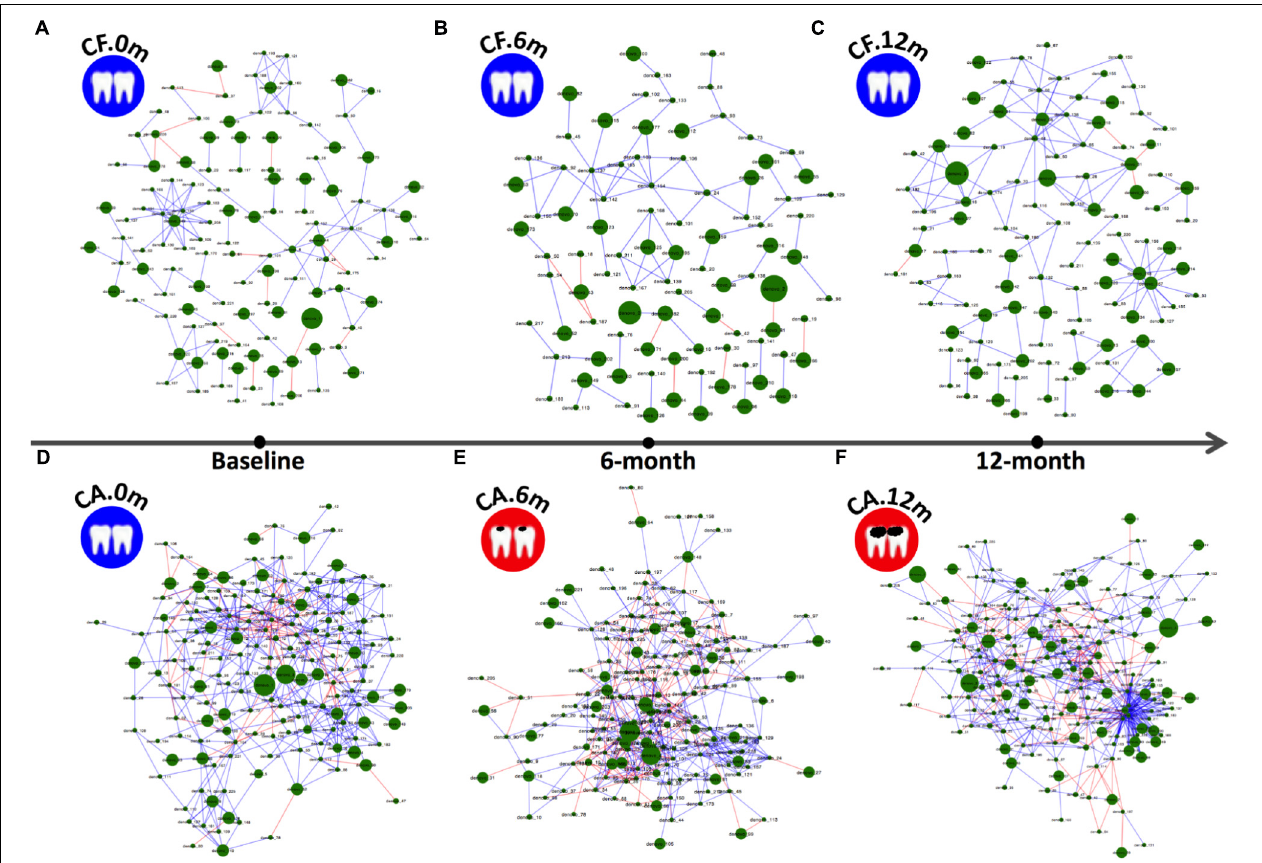
FIGURE 2 | Co-occurring network and corresponding OTUs in supragingival microbiome of CF and CA groups during follow-up. Blue and red edges indicate positive ( r > 0.4) and negative correlations ( r < –0.4), respectively. The area of each node indicates the corresponding OTU’s relative abundance. (A–C) OTU co-occurring networks of supragingival microbiome of the CF group during follow-up. (D–F) OTU co-occurring networks of supragingival microbiome of the CA group during